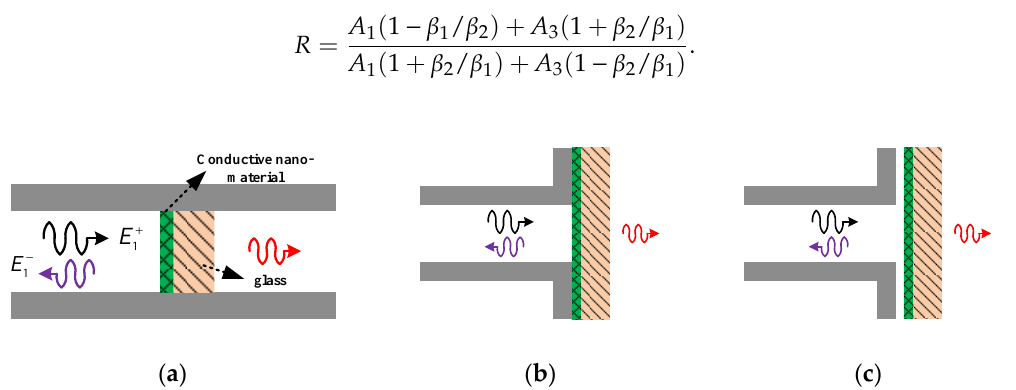
Figure 2. ( a ) Ideal model; ( b ) nonideal model for contact case; ( c ) nonideal model for contactless case.